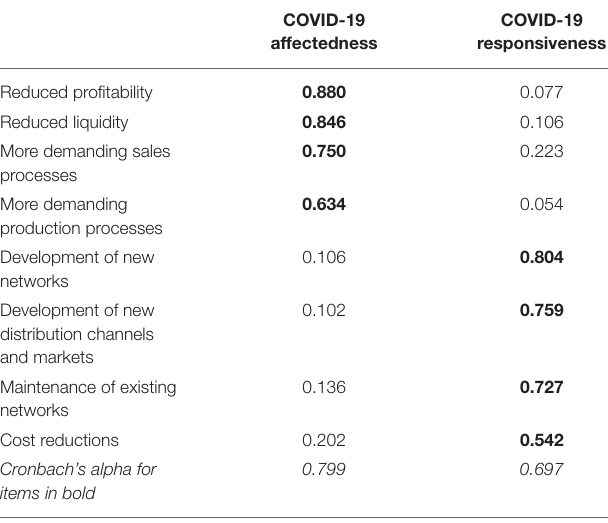
TABLE 1 | Factor analysis with orthogonal varimax